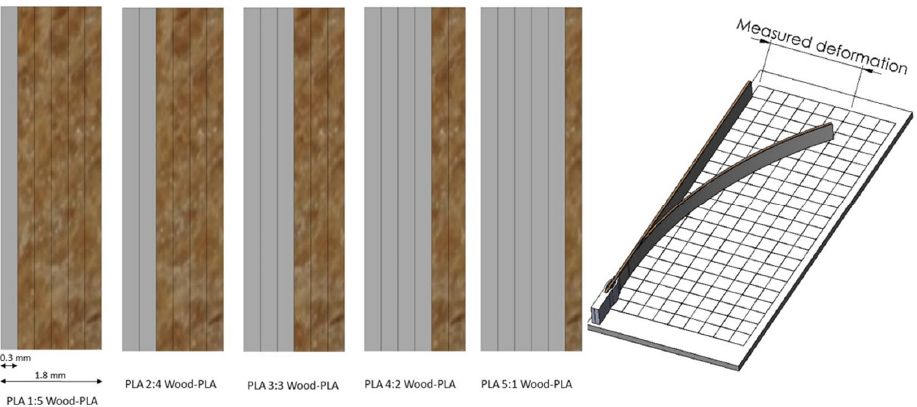
Figure 1. The composition of the actuator samples ( left ) and the mounted sample on the measuring template to determine the hygroscopic deflection ( right ).